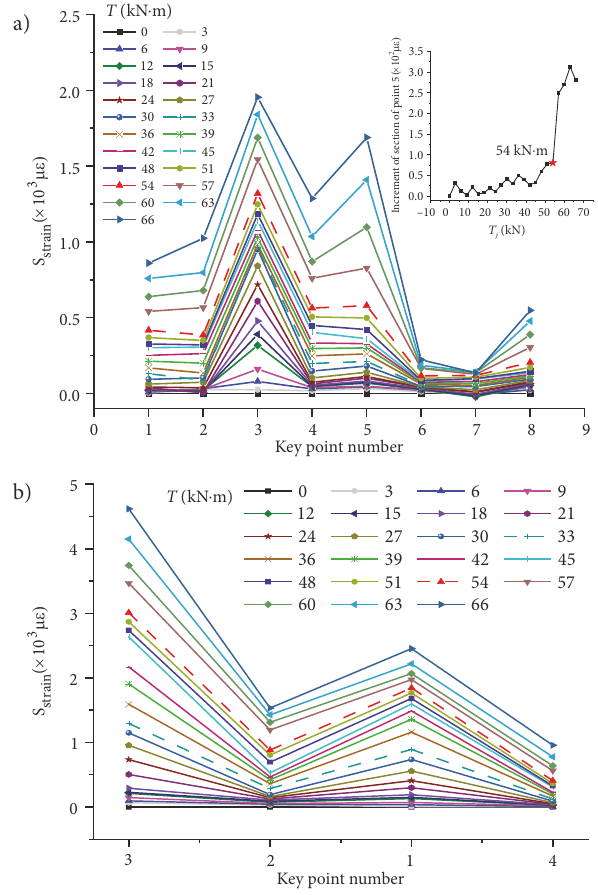
Figure 6. The changing features of strain-based stressing state mode: a – the pattern of stressing state mode for stirrup at L/4 cross section; b – the pattern of stressing state mode for CFRP at L/4 cross section